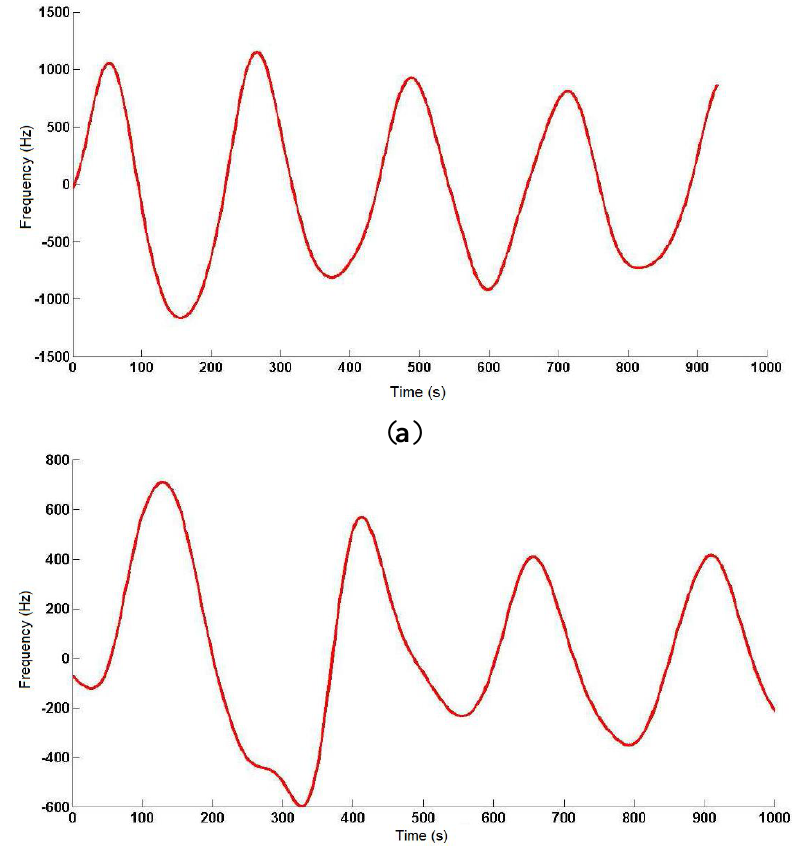
Figure 9. Output signal after the third-stage processing of both volunteer